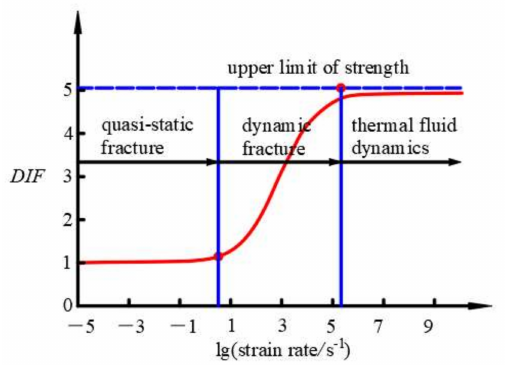
Figure 3. Diagrammatic sketch of relationship between DIF and strain